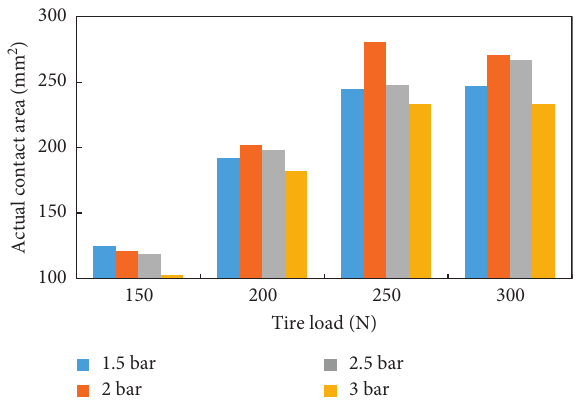
Figure 4: The actual contact area based on different tire